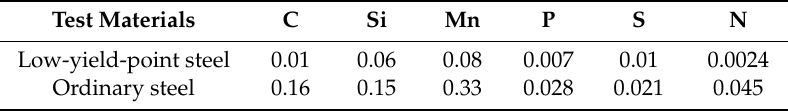
Table 2. Chemical compositions of test materials (unit: %).